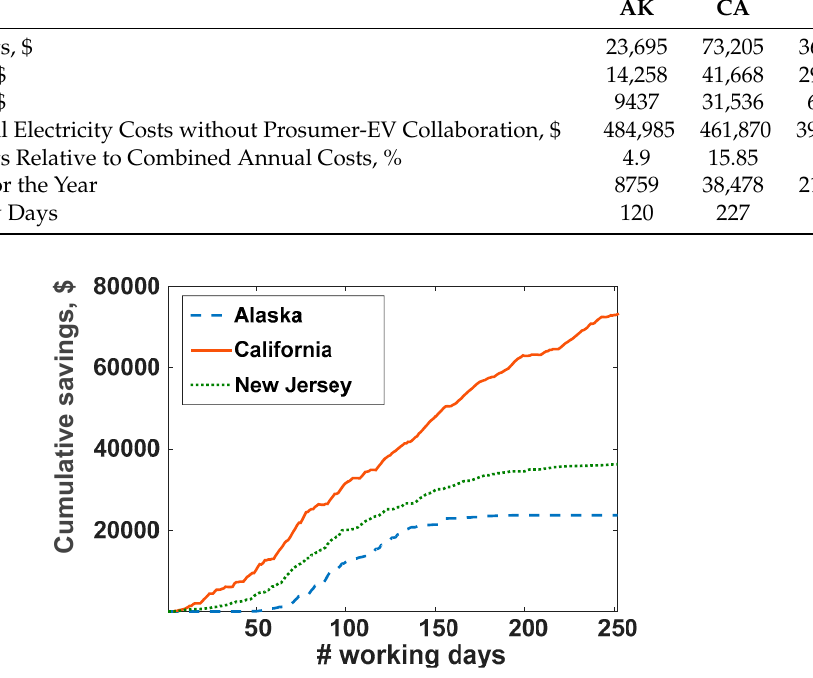
Figure 6. The overall cumulative savings for prosumers and EV owners during the year in three different states.